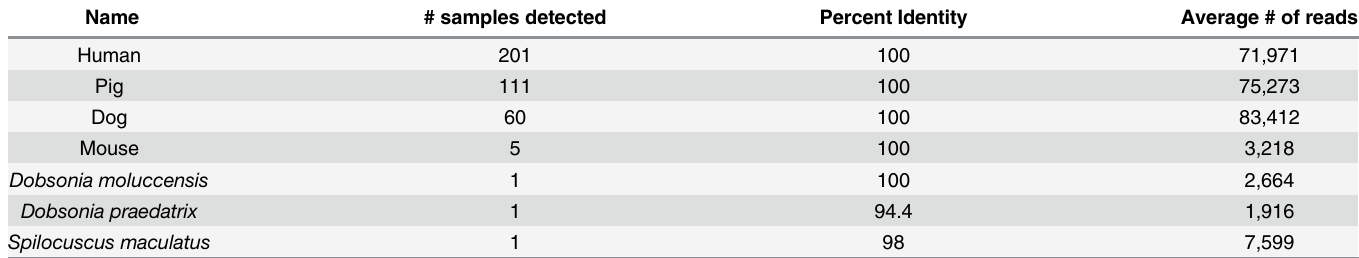
Table 2. Summary of the hosts identified in the mosquito blood meals. For each host, the number of Anopheles mosquitoes carrying a corresponding DNA sequencing is indicated as well as the highest percent identity between the read generated and the host DNA sequence in NCBI and the average num- ber of reads per sample carrying each DNA